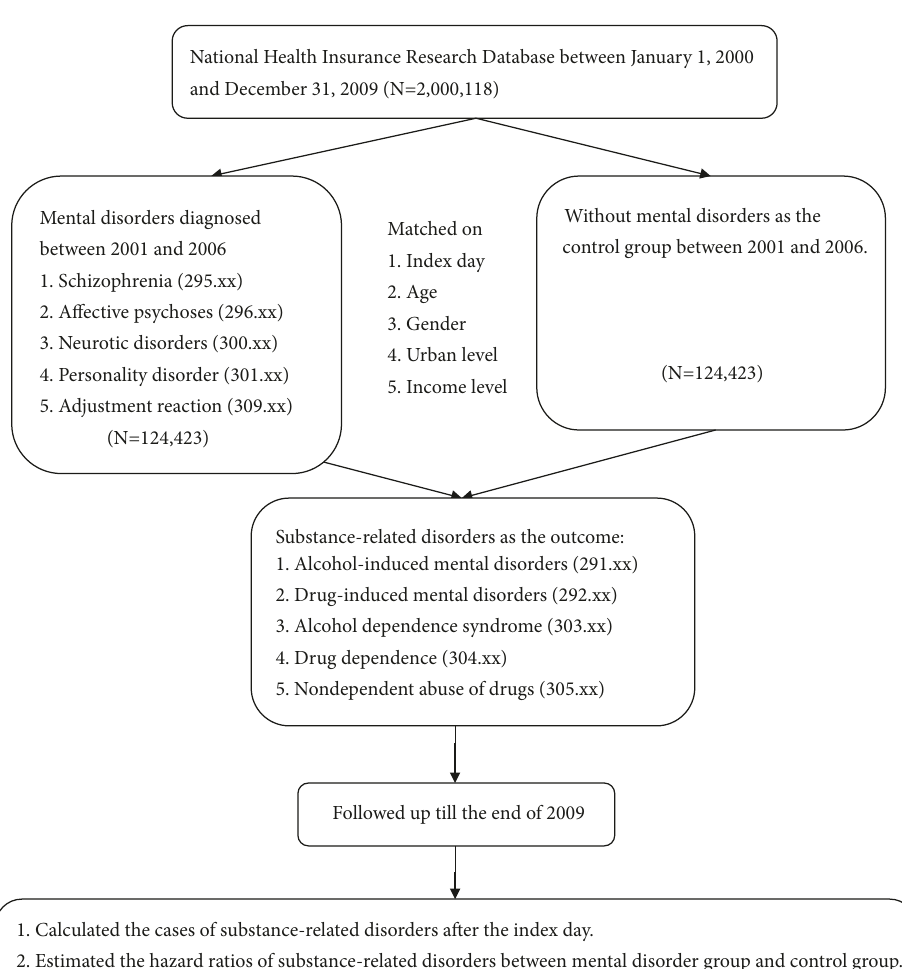
Figure 1: Study flow.